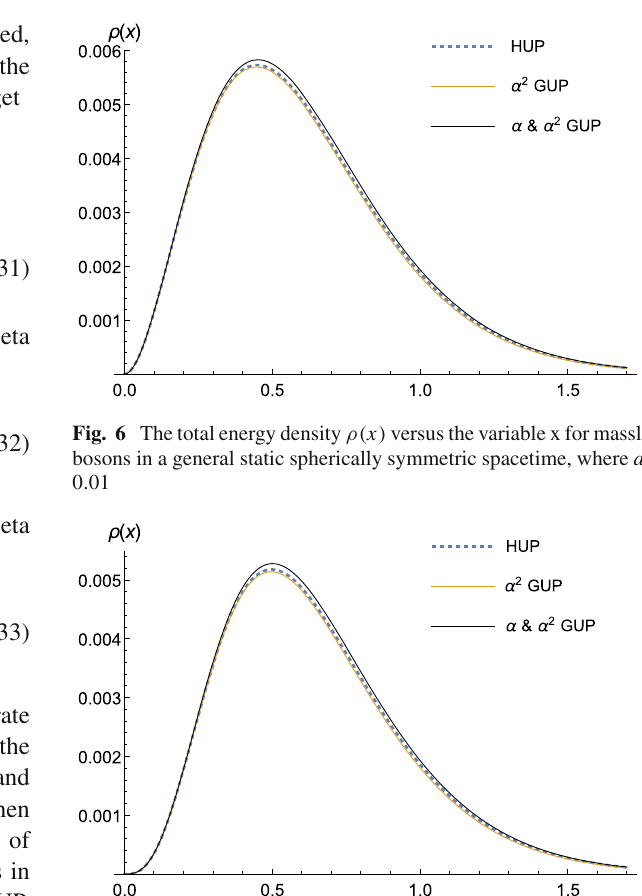
Fig. 5 The total energy density ρ( x ) versus the variable x for massless fermions in a general static spherically symmetric spacetime, where a = 1